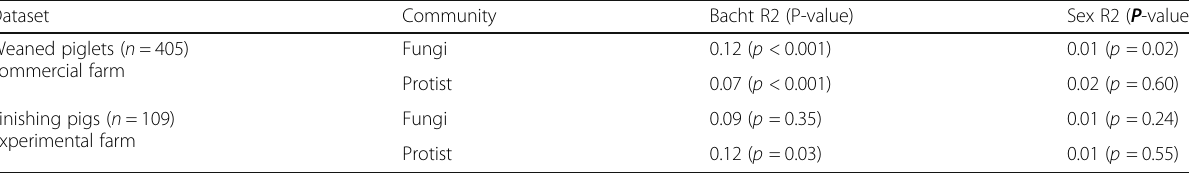
Table 1 Resume of the permutational multivariate analysis of variance